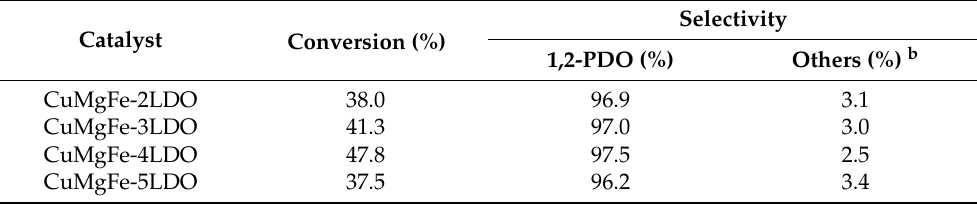
Table 3. Hydrogenolysis of glycerol on reduced CuMgFe-xLDO catalysts a . Catalyst Conversion